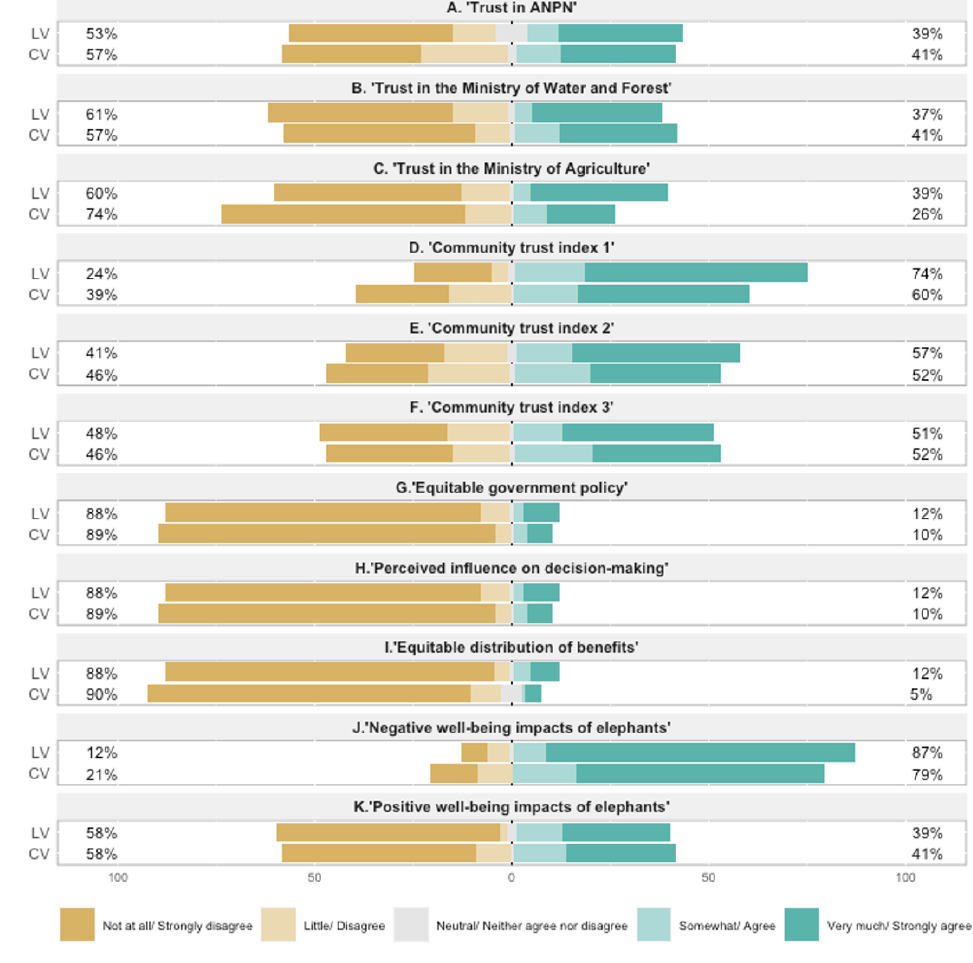
Fig. 4. Diverging stacked-bar charts of attitudinal trust and equity. (A–C) Statements were based on “Not at all” to “Very much” Likert scales. (D–K) Statements were based on “Strongly disagree” to “Strongly agree”. CP = conservation-influenced villages, LV = logging-influenced